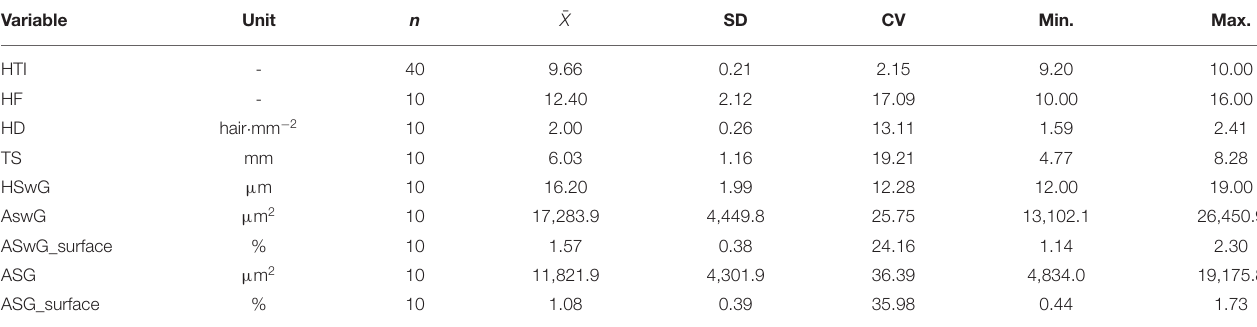
TABLE 2 | Number of observations ( n ), averages ( ¯ X ), standard deviation (SD) coefficient of variation (CV), minimum (Min.) and maximum (Max.) values for the heat tolerance index, and histomorphometric characteristics of the skin of adult female buffaloes reared in the Eastern